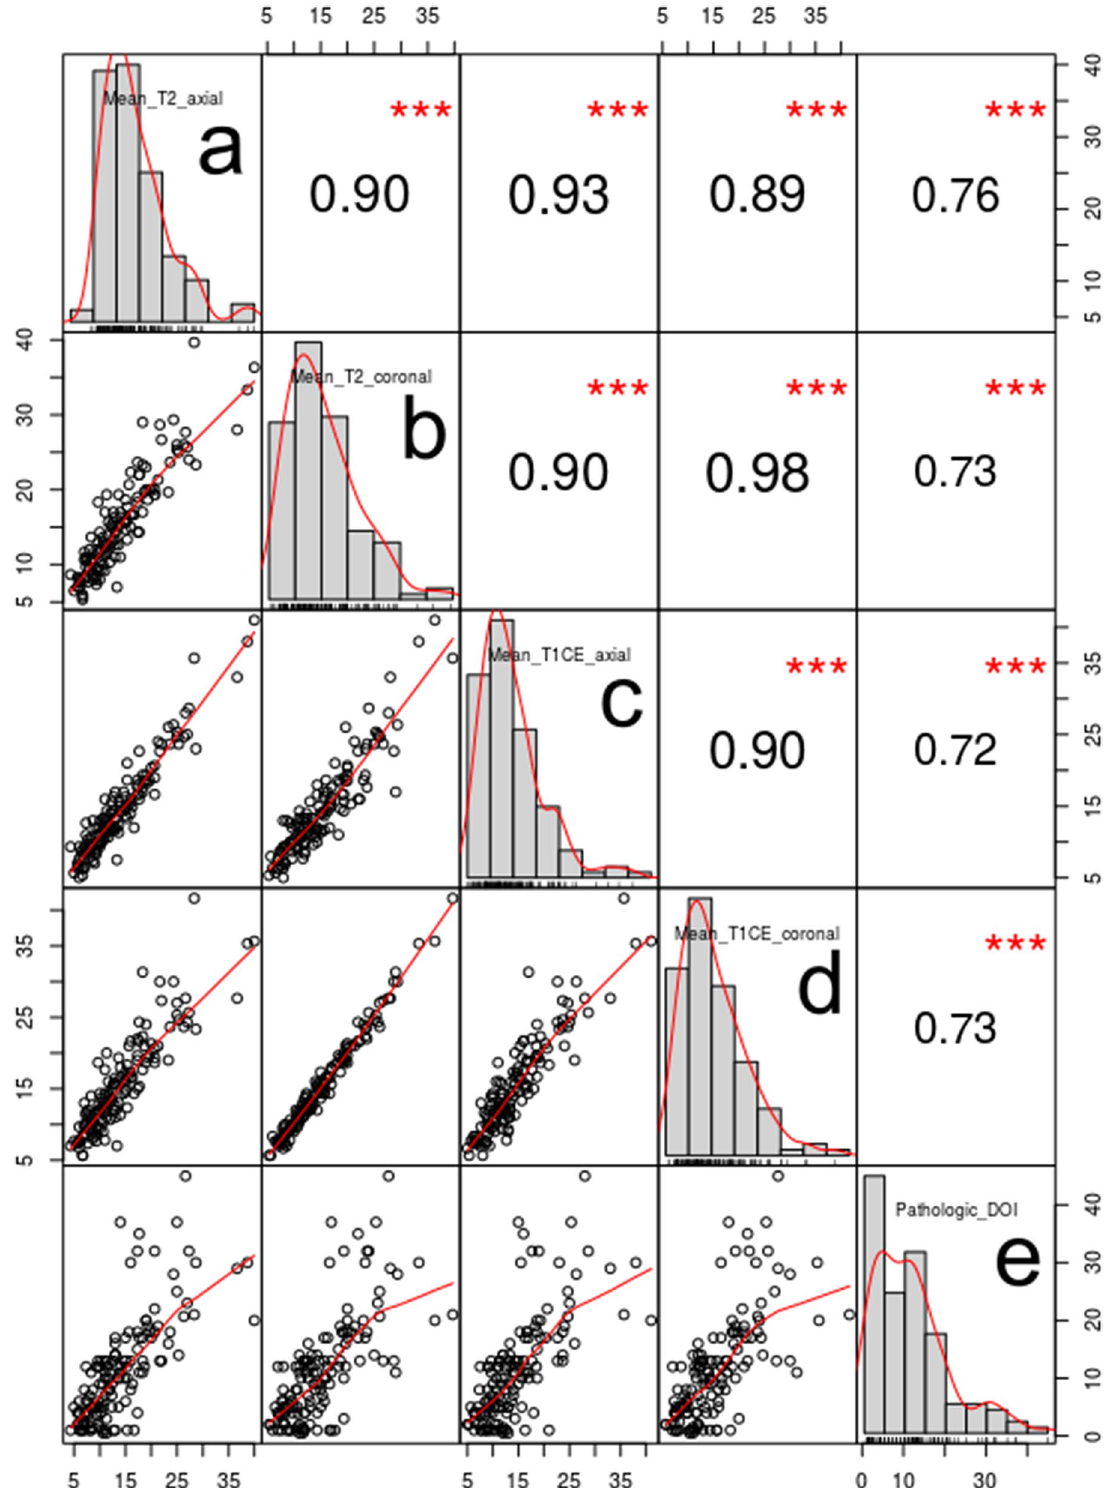
Figure 3. Correlation matrix of MRI-measured tumor thickness (MRI-TT), ( a ) axial T2WI, ( b ) coronal T2WI, ( c ) axial CE-T1WI, ( d ) coronal CE-T1WI, and ( e ) pathologic depth of invasion (pDOI). The numbers on the x- and y-axes indicate MRI-TT or pDOI in millimeters. Spearman rank correlation coefficients are shown with three stars indicating P < 0.001 (top right). Bivariate scatterplots are shown with fitted lines (bottom